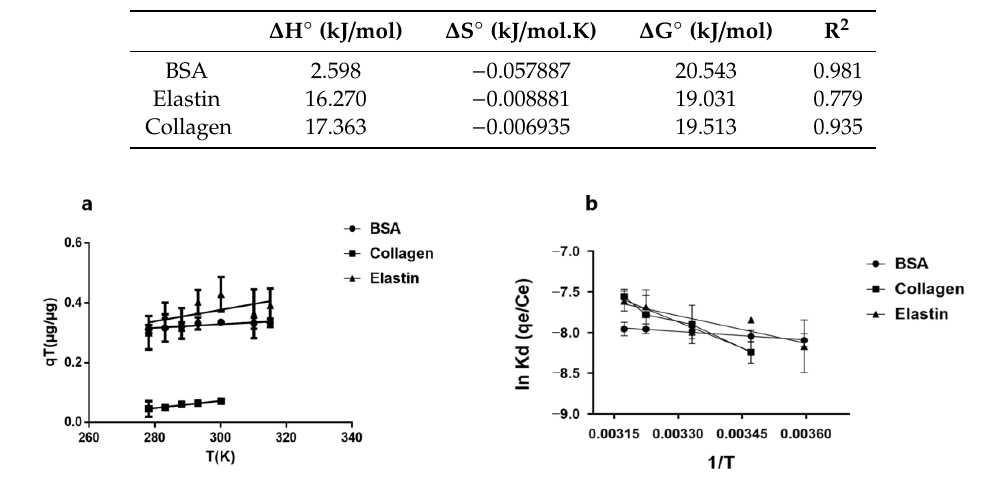
Table 5. Thermodynamic parameters. Enthalpy change: ∆ H ◦ ; Entropy change: ∆ S ◦ ; Gibbs free energy change: ∆ G ◦ at 300 K.